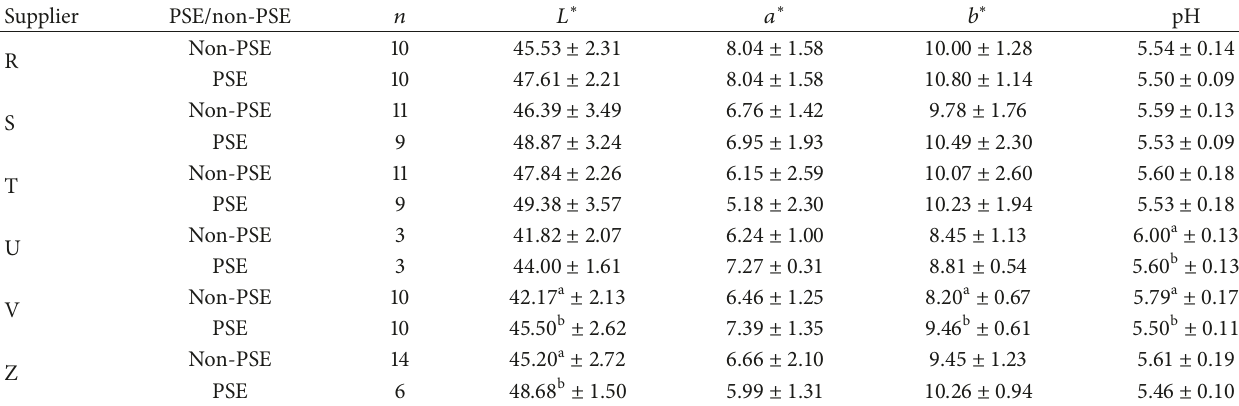
Table 3: Physical properties of m. semimembranosus muscle identified as PSE and non-PSE (means ± SD). The colour of m. semimembranosus (SM) was measured by the CIELAB system; the pH value was detected by a pH meter with a Double Pore needle probe.